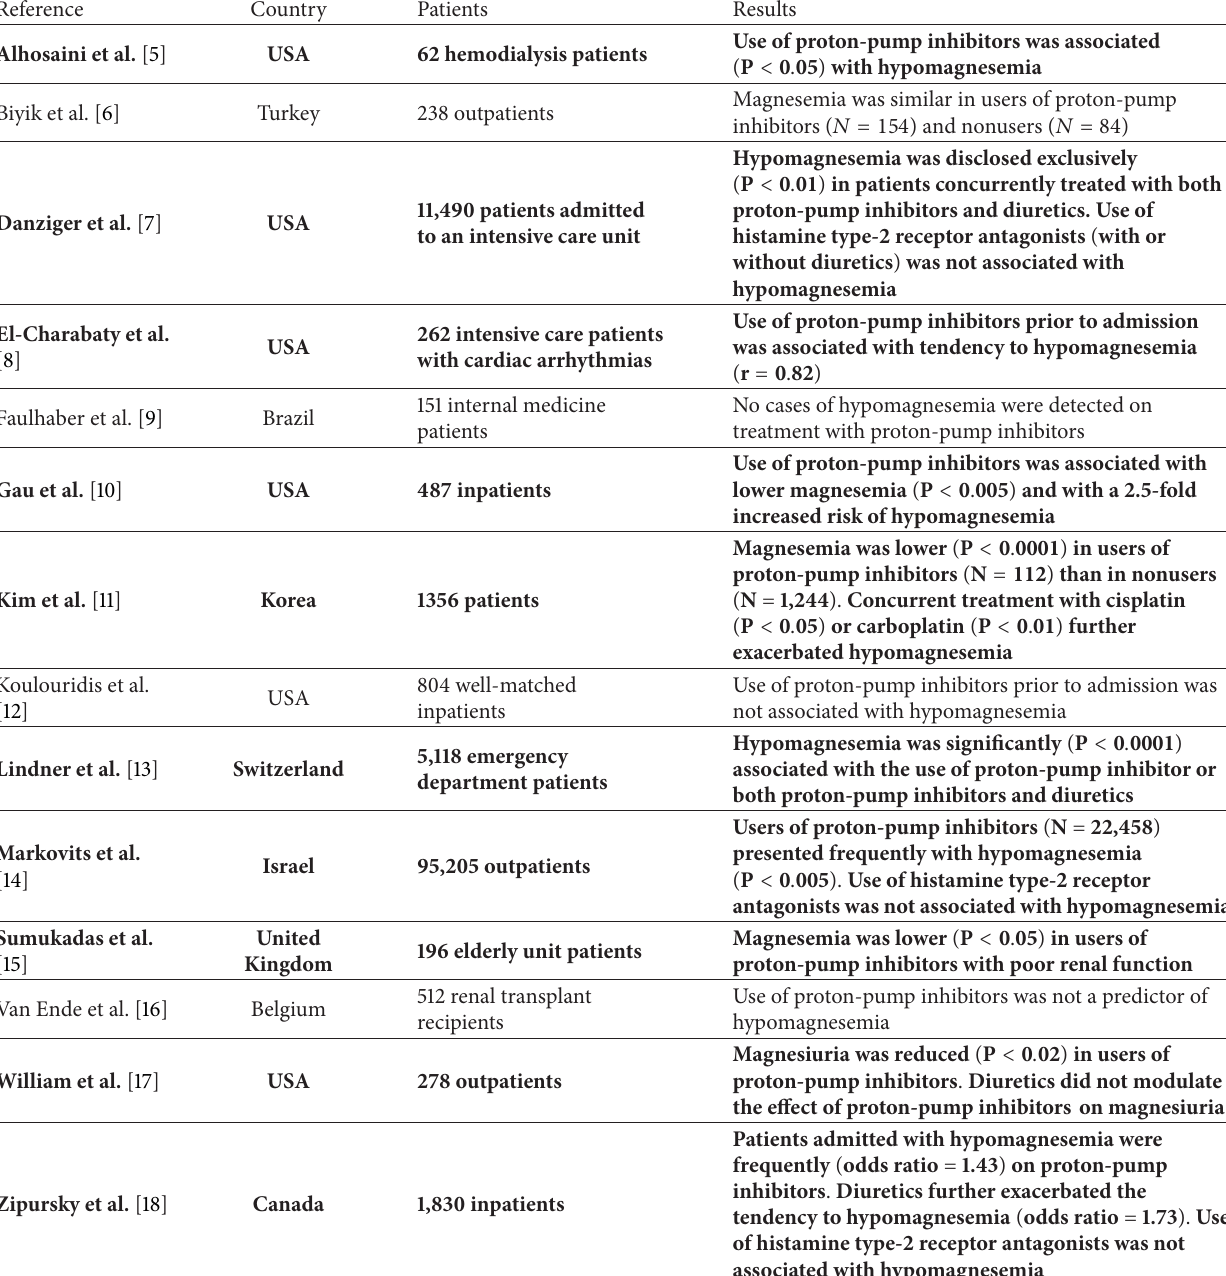
Table 2: Case-control, cross-sectional studies addressing the potential of proton-pump inhibitors to modulate the metabolism of magnesium. Reports disclosing a significant relationship between use of these drugs and metabolism of magnesium are